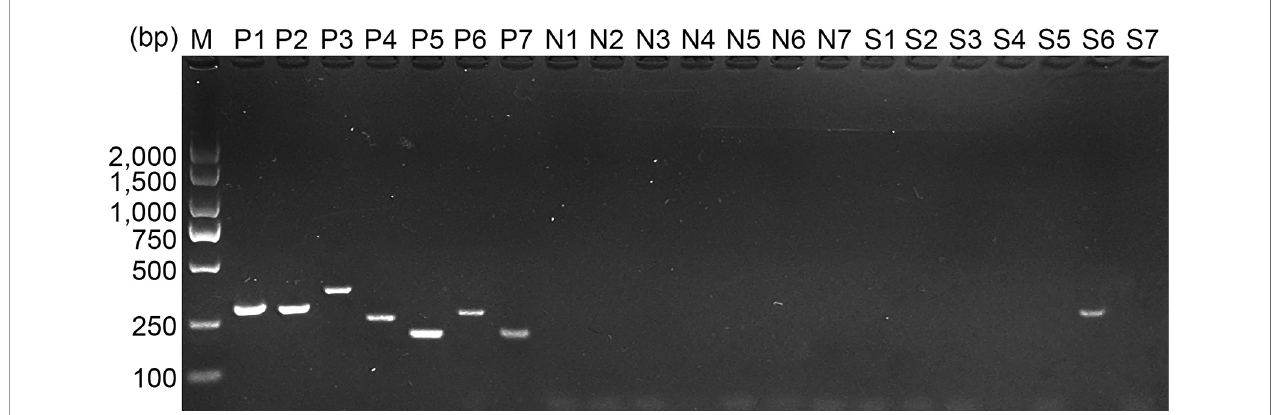
FIGURE 1 | Molecular identi fi cation of E. mitis sporulated oocysts. Eimeria species were detected by PCR ampli fi cation based on the internal transcribed spacer 1 (ITS1) sequence. Line M: DL2,000 marker; Lines P1 – P7: positive control for E. acervulina , E. brunetti , E. necatrix , E. tenella , E. maxima , E. mitis , and E. praecox ; Lines N1 – N7: negative control for E. acervulina , E. brunetti , E. necatrix , E. tenella , E. maxima , E. mitis , and E. praecox ; Lines S1 – S7: DNA extracts for E. acervulina , E. brunetti , E. necatrix , E. tenella , E. maxima , E. mitis , and E. praecox